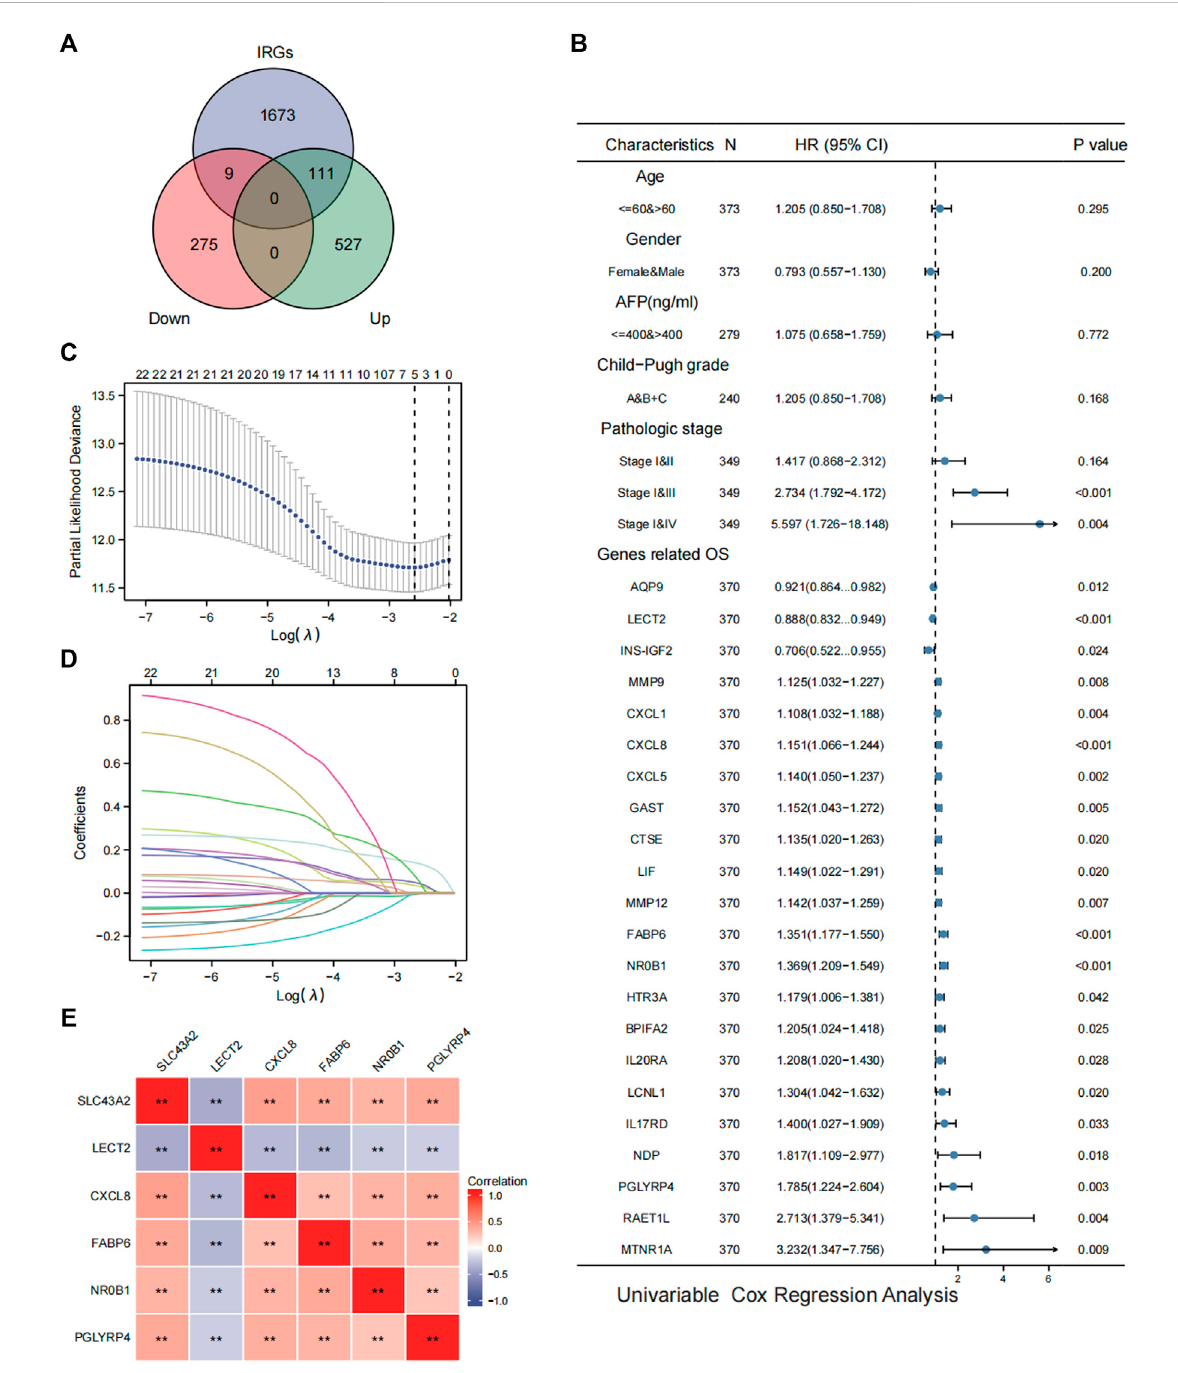
FIGURE 6 Analysis of SLC43A2 related IRGs in LIHC. Venn diagrams showing the intersection of the IRGs and SLC43A2-related DEGs in LIHC, which was de fi nedasSLC43A2-relatedIRGs (A) .ForestplotsshowingtheresultsofunivariateCoxregressionanalysisofOSbasedonclinicopathologicalfactors (such as age, gender, AFP, Child-Pugh grade and stage) and SLC43A2 IRGs [ (B) , only the 22 IRGs signi fi cantly associated with OS were shown]. Five genes( LECT2 , CXCL8 , FABP6 , NR0B1 , PGLYRP4 )werefurtherlyselectedfromthe22SLC43A2relatedIRGsbytheLASSOCoxregression (C,D) . Correlation of SLC43A2 with the 5 genes (LECT2, CXCL8, FABP6, NR0B1, and PGLYRP4) (** p < 0.01) (E)